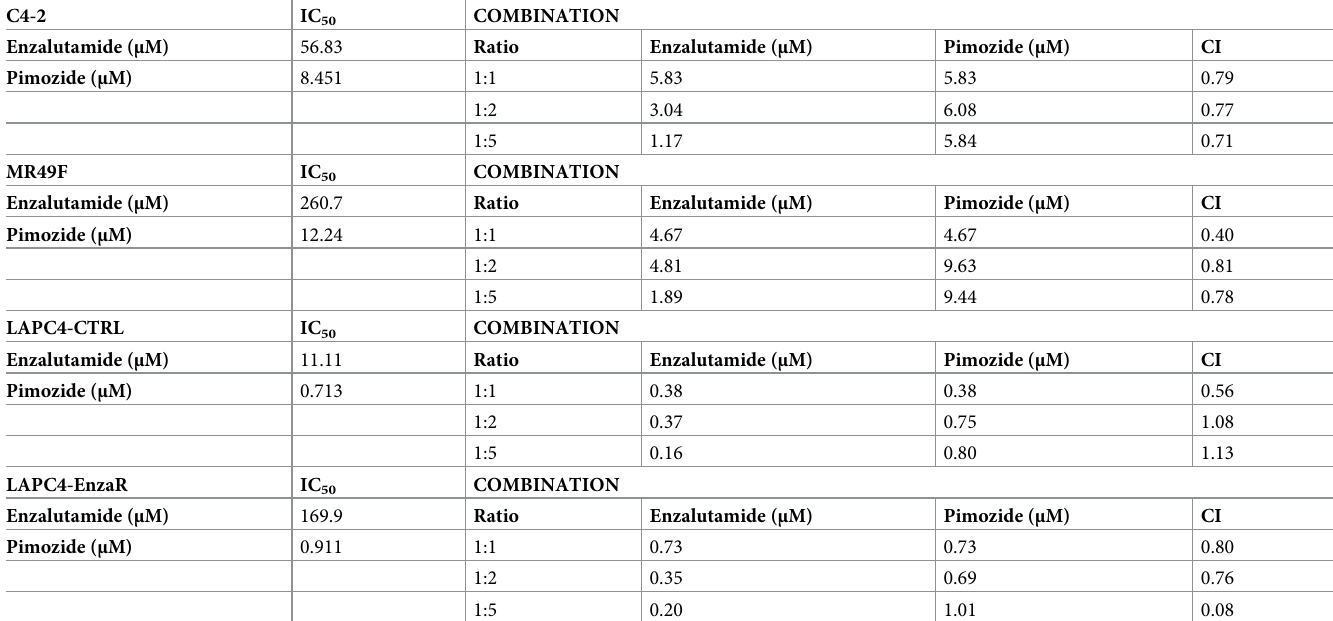
Table 1. Summary of isobologram analysis.